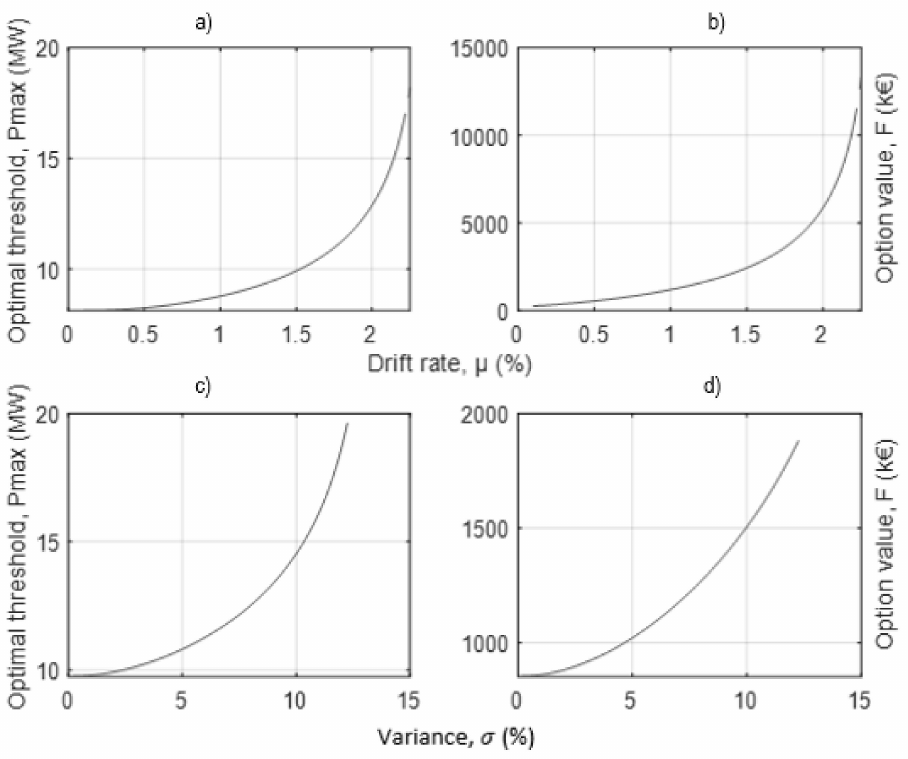
Figure 11. Sensitivity analysis of drift rate and variance for optimal threshold ( a , c ) and option value ( b , d